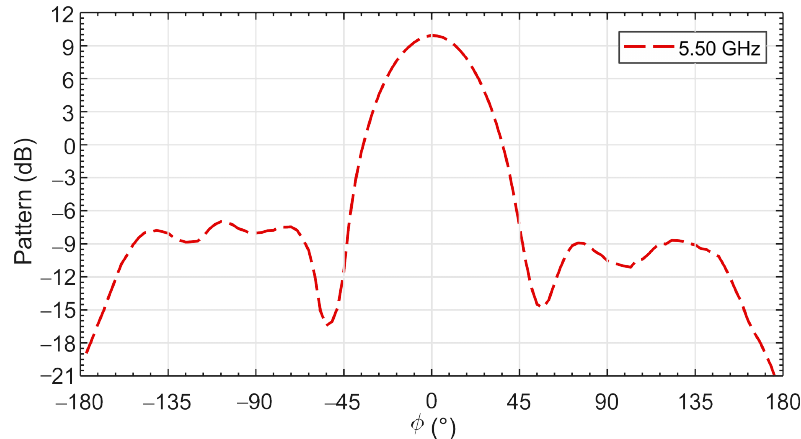
Figure 6. Radiation pattern of each SBA element.